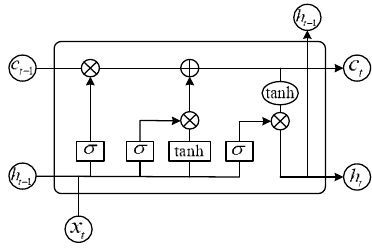
Figure 3. LSTM cell state structure.